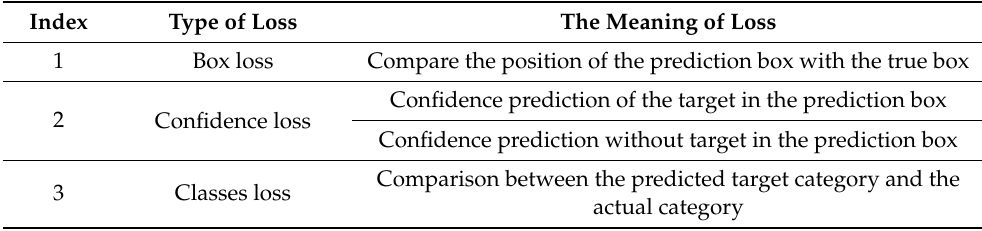
Table 1. YOLOv3 loss function